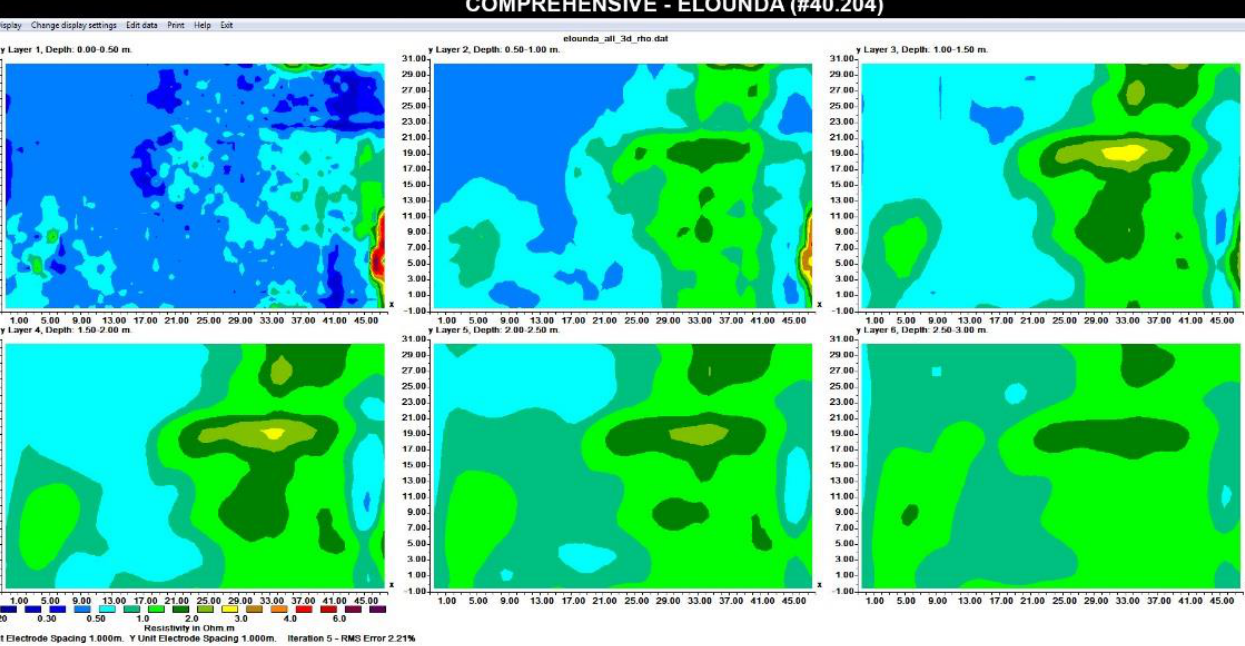
Figure 17. Inversion results from the comprehensive Elounda field data set. Figure 18. Inversion results from the comprehensive Elounda field data